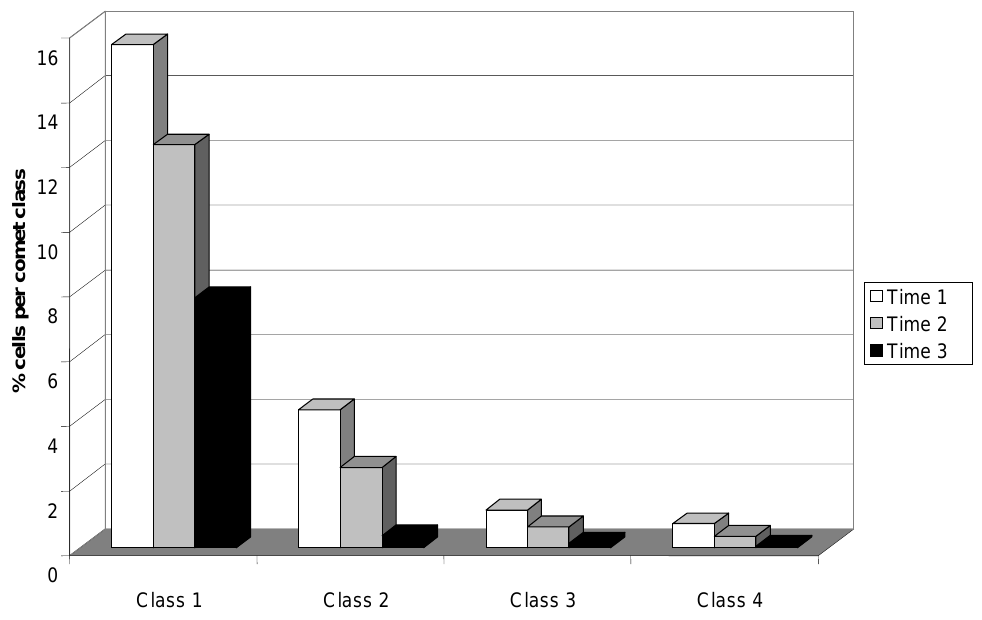
Figure 3. Comparison of the frequency of damaged cells of each comet class between Time Points 1, 2, and 3; Class 0: no damage; Class 1: with a tail lower than the diameter of the head (nucleus); Class 2: with a tail length from one- to two-times the diameter of the head; Class 3: with a tail greater than two-times the diameter of the head; Class 4: small head (with tail width greater than the nucleus diameter); Time 1: beginning of withdrawal; Time 2: 48 h after withdrawal; Time 3: at the end of the treatment period (21 to 30 days after